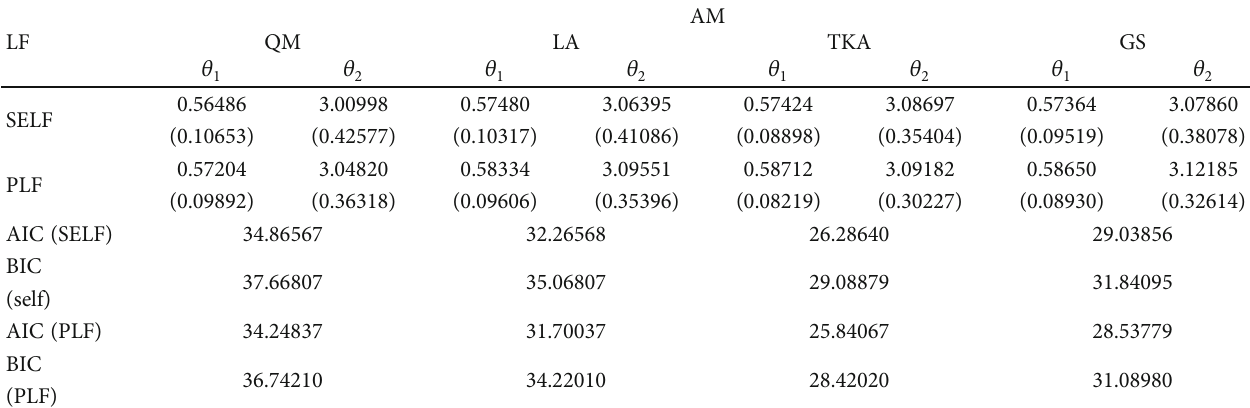
Table 12: BEs and PRs (in parentheses) using real